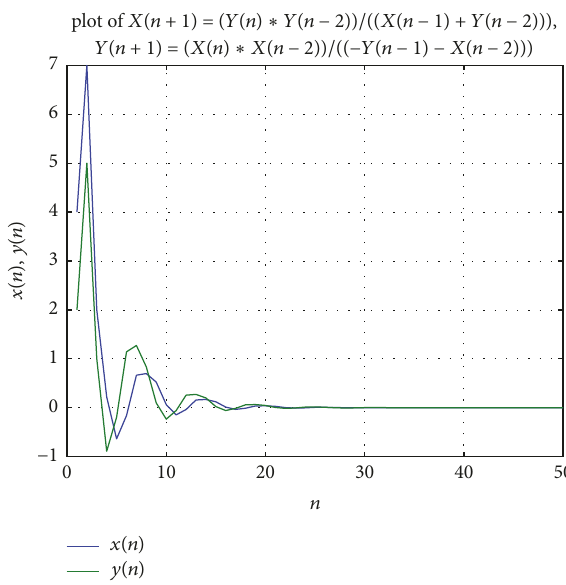
Figure 2: This figure shows the solution of (17).